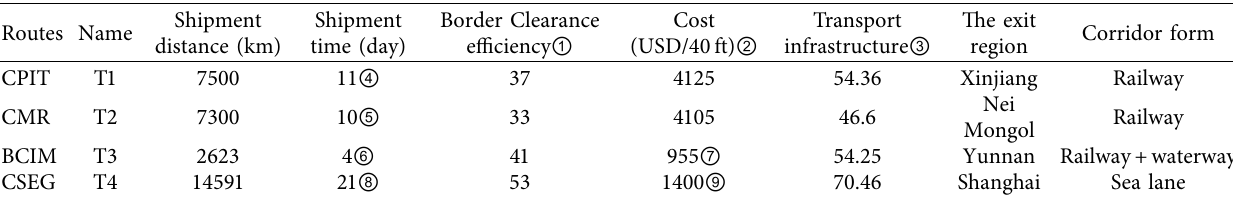
Table 1: Comparative metrics of T1, T2, T3, and